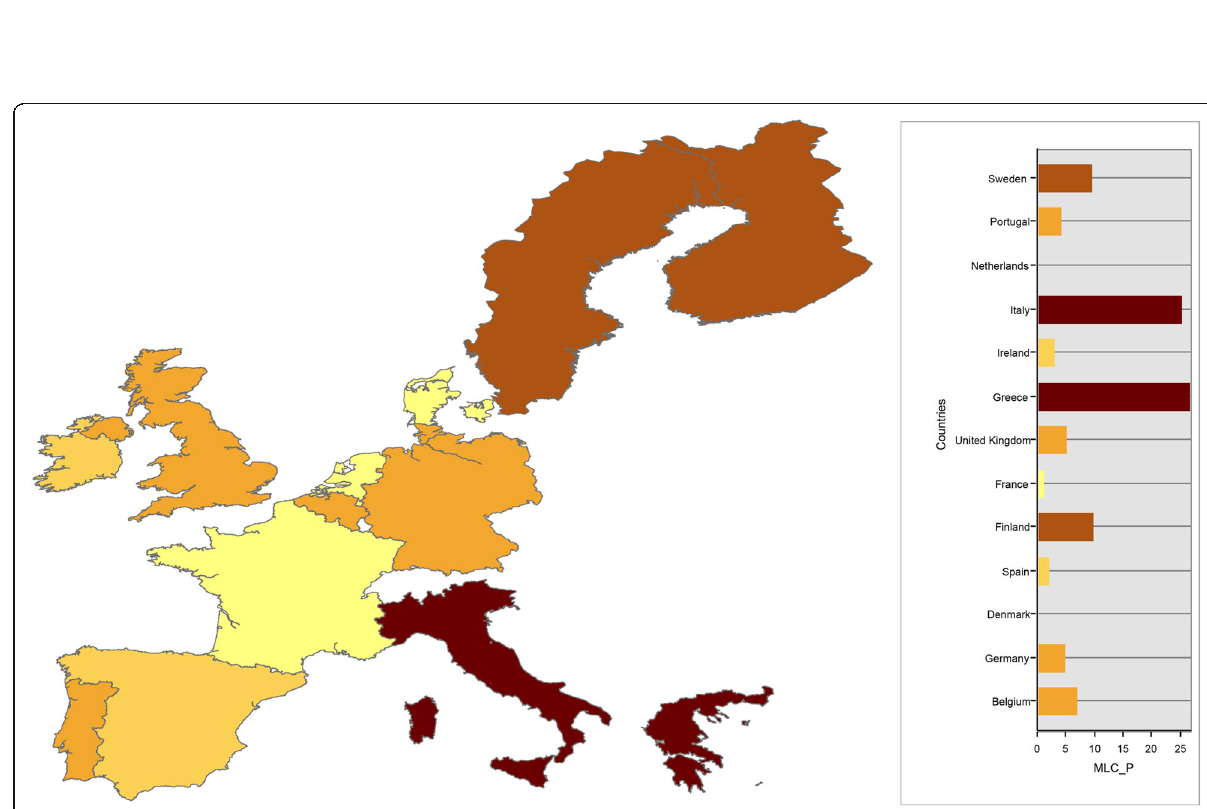
Fig. 18 Detainable remarks percentage for Maritime Labor Convention for EU15